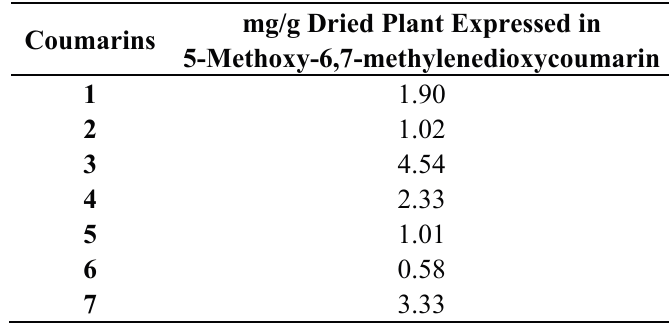
Table 3. Coumarin contents in the aqueous extract of P. balansae